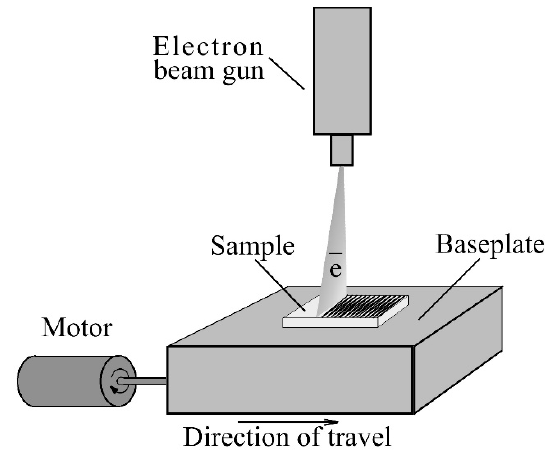
Figure 1. Experimental setup for electron beam post-treatment of the surface of Ti–6Al–4V parts.